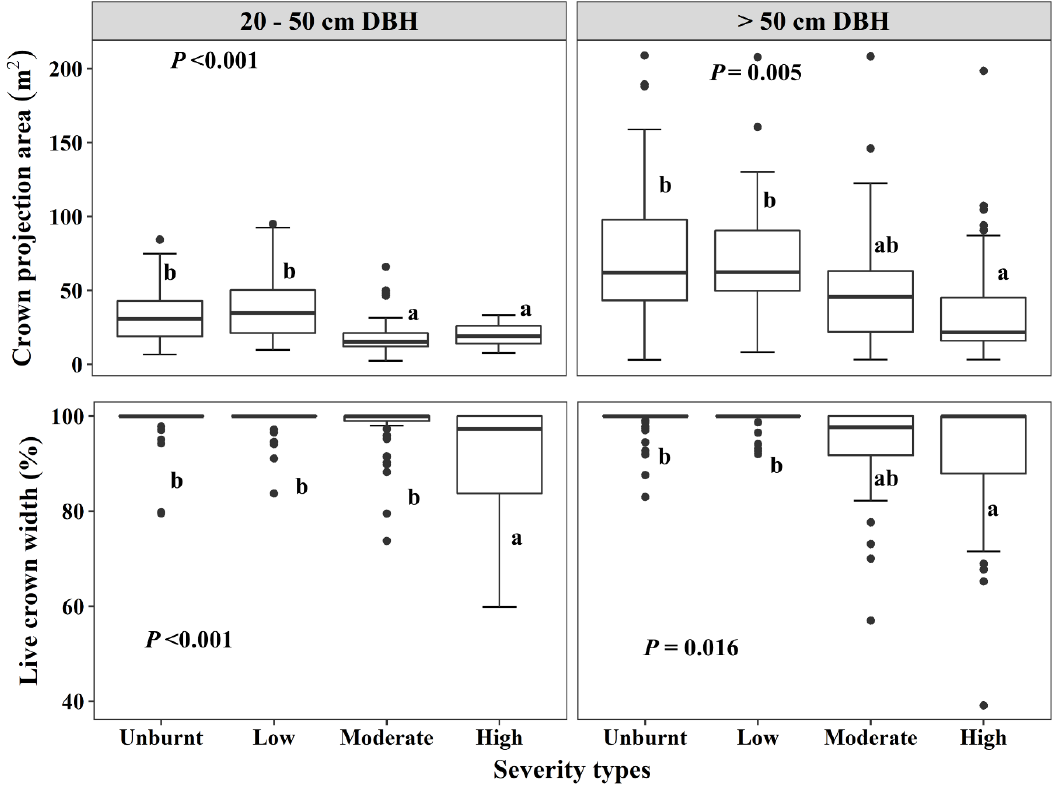
Figure 6. Comparison of field-measured horizontal crown metrics—crown projection area, and live crown width—among fire-severity types for both mature (left panels) and larger trees. Graphs are standard boxplots (median as centre line), based on 20 to 59 trees per diameter class for each of the severity types (20–50 cm: UB—34, L—51, M—49, H—20; > 50 cm: UB—45, L—40, M—44, H—59). P-values are calculated from LMEM, and different letters indicate significant differences between fire-severity types as indicated by post hoc tests (Fisher’s LSD test).